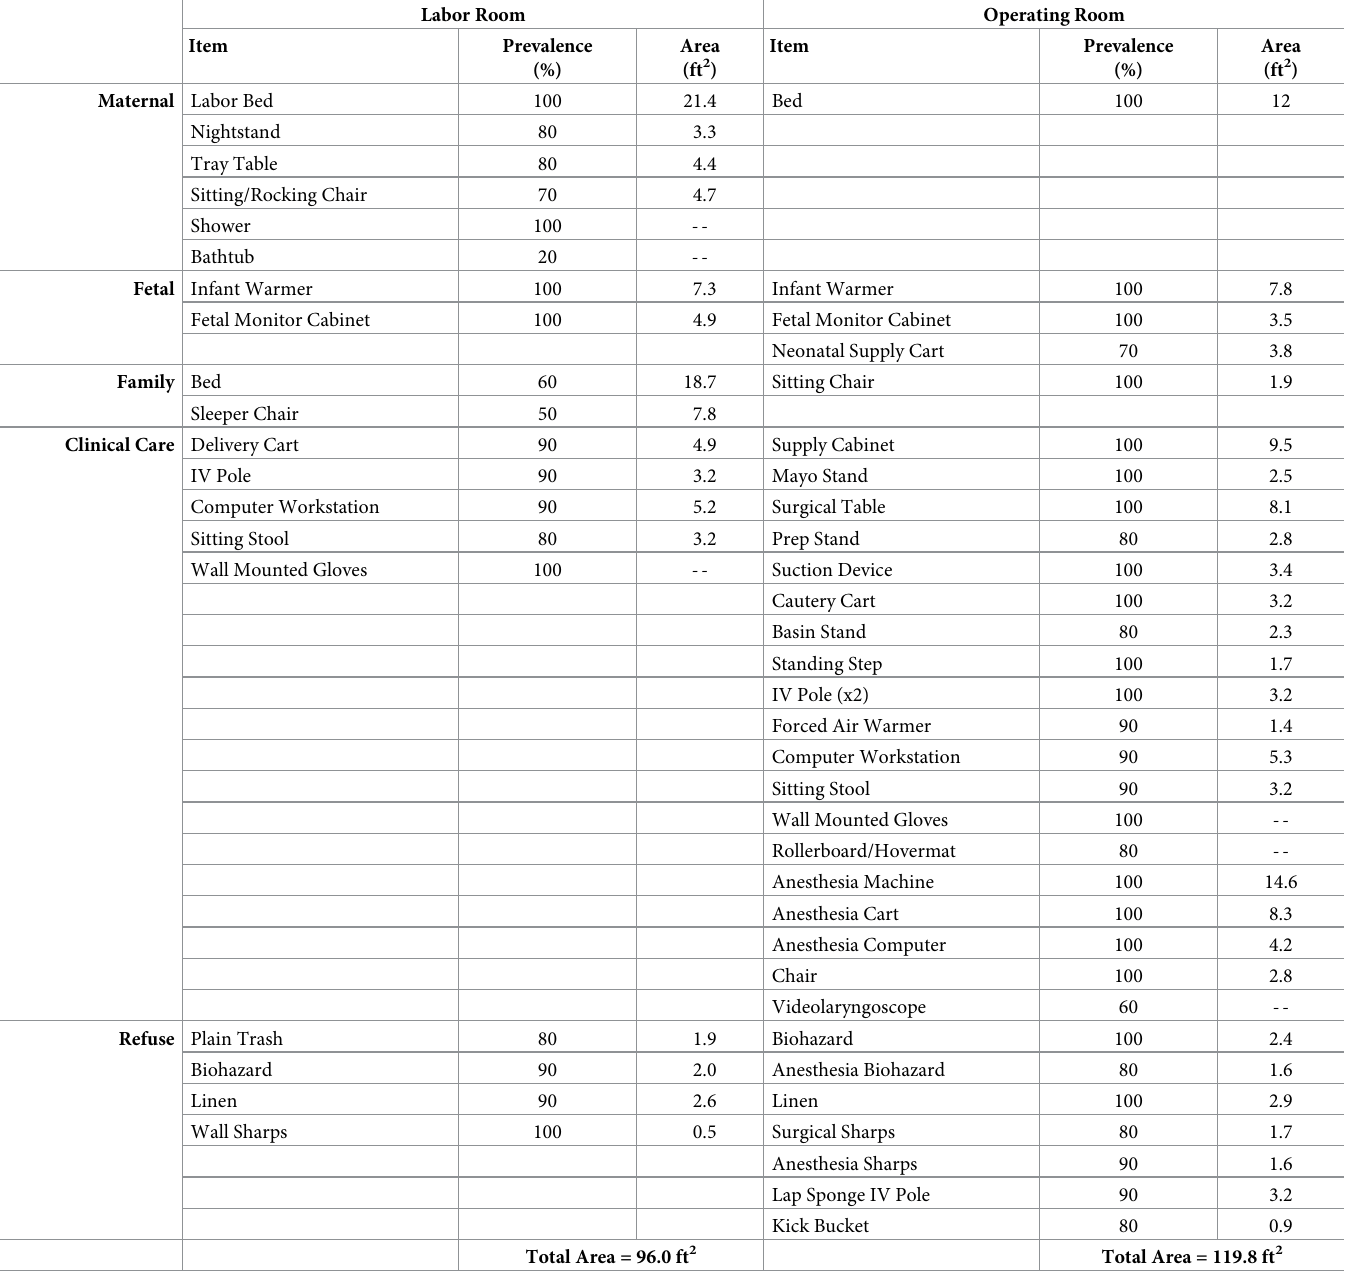
Table 2. Inventory of equipment in labor and operating